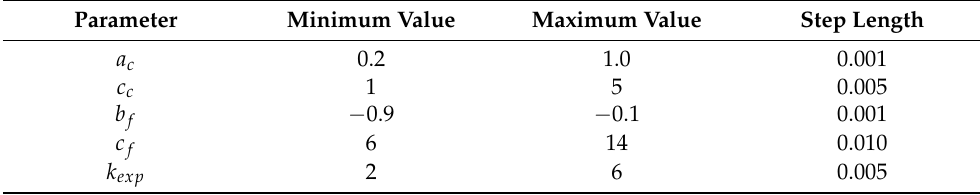
Table 2. The boundaries of the parameter space and the step length1 for the second estimation. Parameter Minimum